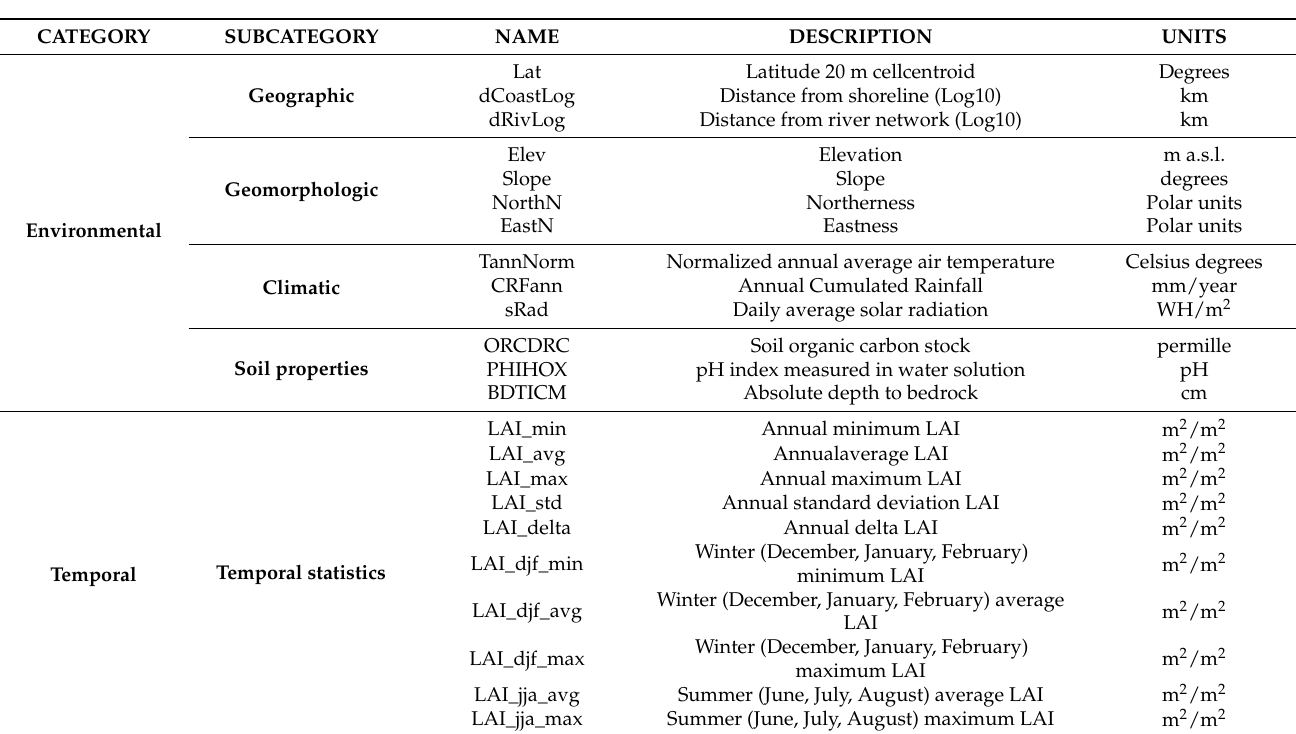
Table A1. List of variables used as predictors for the analysis of forest habitat types classification. River network and shoreline used to calculate distance from shoreline and distance from river network was MATTM National Geoportal (http://www.pcn.minambiente.it/mattm/catalogo-metadati/, accessed on 12 January 2020); the source for soil properties variables was SoilGrids (https://soilgrids.org, accessed on 16 January 2020); the source for all the others predictors was ISPRA Database (http://www.sinanet.isprambiente.it/it/sia-ispra, accessed on 28 January